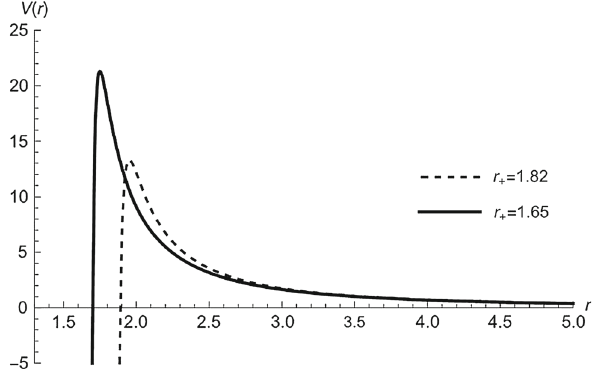
Fig. 1 Superradiantly stable effective potentials. The black hole mass ischosenas M = 1.Thechargesarechosenas Q e = 0 . 4 , Q m = 0 . 4and Q e = 0 . 7 , Q m = 0 . 3 for the solid curve and dashed curve respectively. Theotherparametersarechosenas l = 2 ,ω = 0 . 02 ,μ = 0 . 05 , q = 0 .